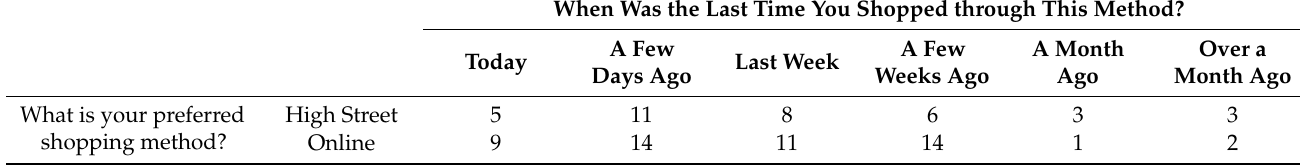
Table 2. Preferred shopping methods of respondents, alongside last time of